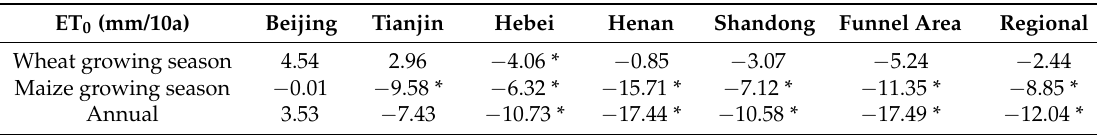
Table 8. The province-wide, funnel area, and regional statistics for the wheat, maize, and annual average evapotranspiration trend.